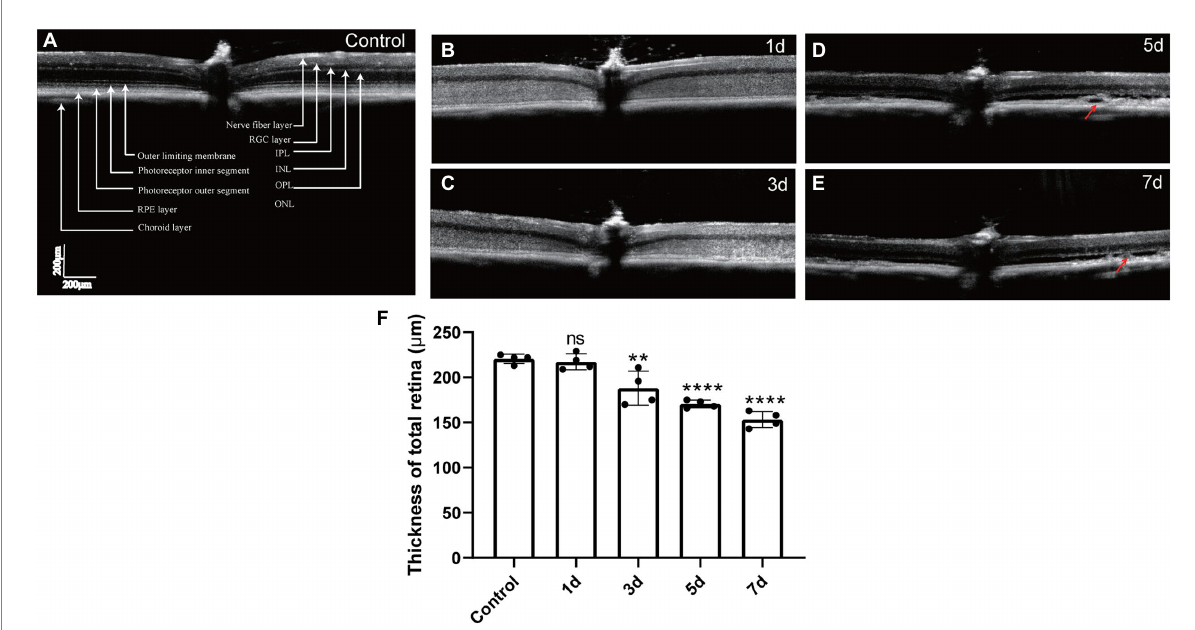
FIGURE 2 The representative OCT images of the retinal structure after MMS treatment with time. (A) the OCT images of the retinal layered structure in control mice. (B–E) The OCT images of control mice and MMS treated mice at different time points. The arrows showed the vacuoles occurred in the RPE layer at 5 and 7 days post MMS injection in panel (D,E) . (Scale bar, 200 μ m) (F) The thickness of the total retina in the MMS treated group compared with the control group by one-way ANOVA, data were expressed as mean ± SD, n = 3/group, ** p < 0.01, **** p < 0.0001 for differences compared to